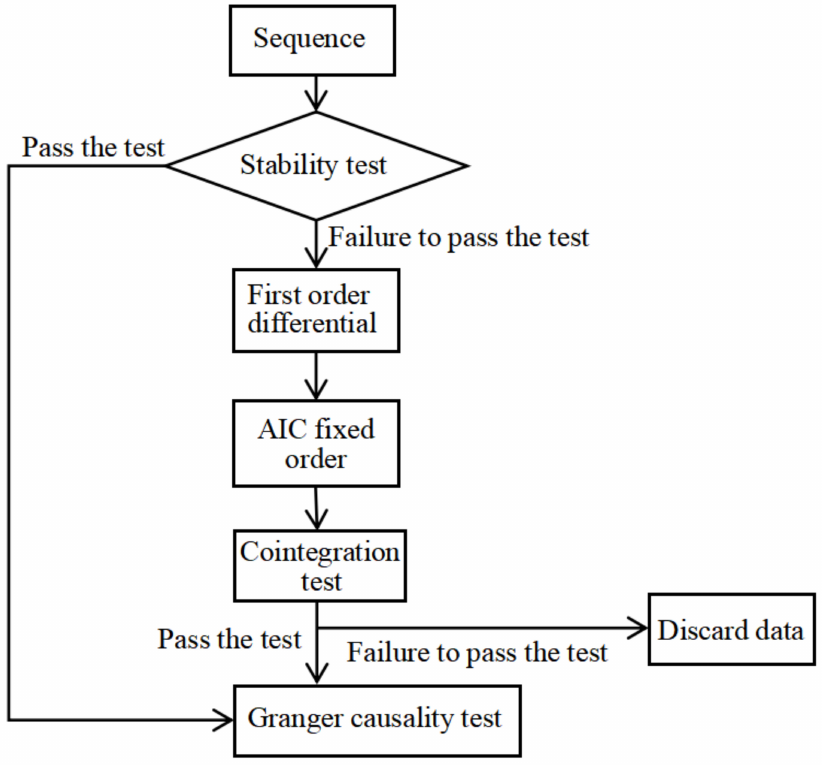
Figure 3. Process of Granger causality